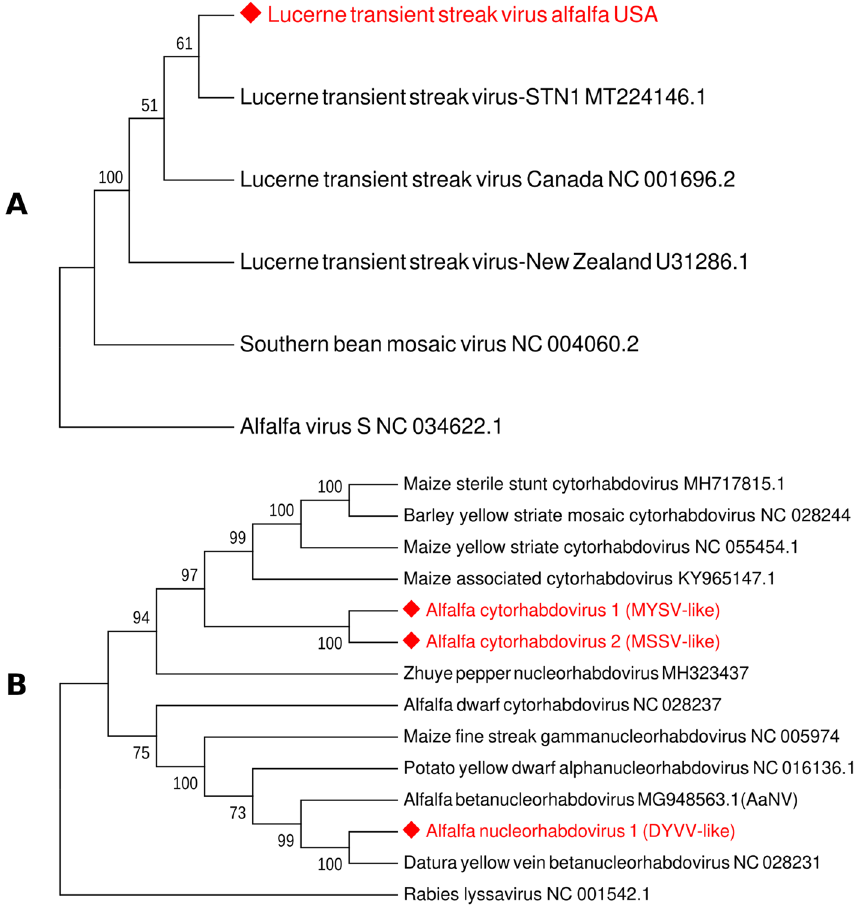
Figure 4. Phylogenetic analysis of lucerne transient streak virus (LTSV) and rhabdoviruses identified in alfalfa samples collected from production fields in the U.S. Pacific Northwest in 2019/2020. ( A ) Phylogenetic relationship of lucerne transient streak virus (LTSVa-US) with other known isolates of LTSV. The tree was deduced from the ClustalW alignment of LTSVa-US and complete nucleotide sequences of other LTSV isolates. Alfalfa virus S (NC 034622.1) was used as an outgroup. ( B ) The phylogenetic relationship between rhabdoviruses identified in this study and several classified or proposed members of the family Rhabdoviridae